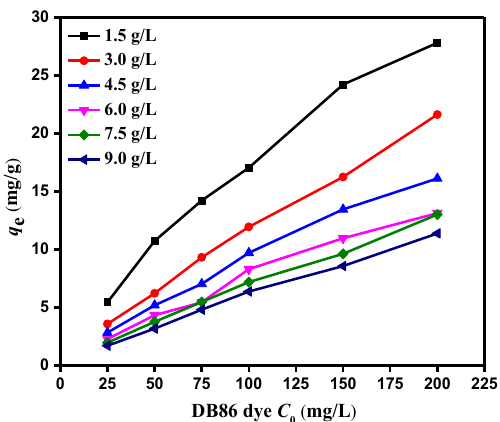
Figure 8. The impact of DB86 dye beginning concentration (25–200 mg/L) using CAH doses (1.5–9.0 g/L) on q e (mg/g), temp. (25 ± 2